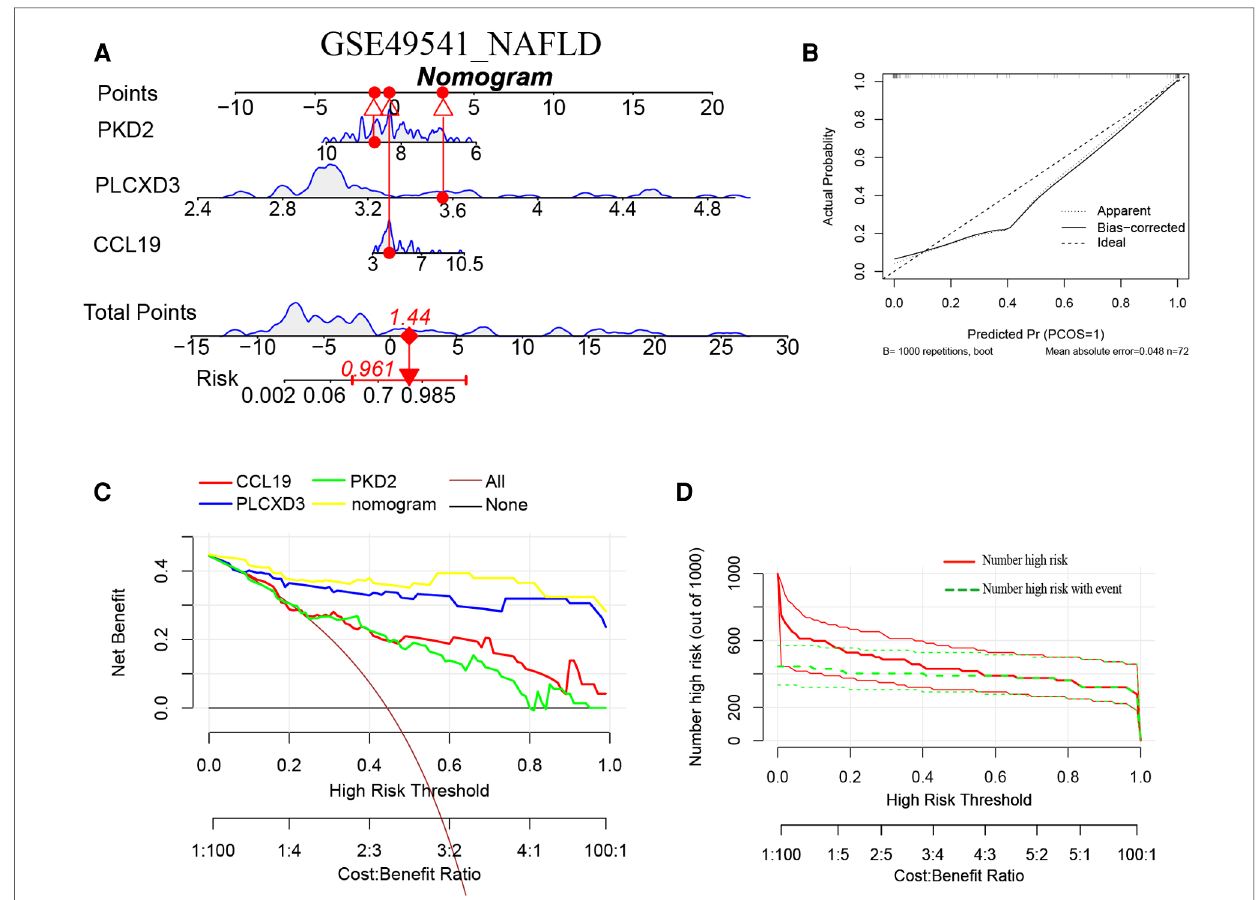
FIGURE 6 ( A ) The nomogram model predicting NAFLD based on three common signature genes in GSE49541. The nomogram is used by summing all points identi fi ed on the scale for each variable. The total points projected on the bottom scales indicate the probabilities of NAFLD; ( B ) the calibration curves for the nomogram with the mean absolute error=0.048; ( C ) DCA of the nomogram model and each common signature gene (the “ All ” means diagnosis-all strategy; the “ None ” means diagnosis-none strategy) and the nomogram model had the highest net bene fi t at all practical risk thresholds (from 0 to 1.0); ( D ) the CIC of the nomogram